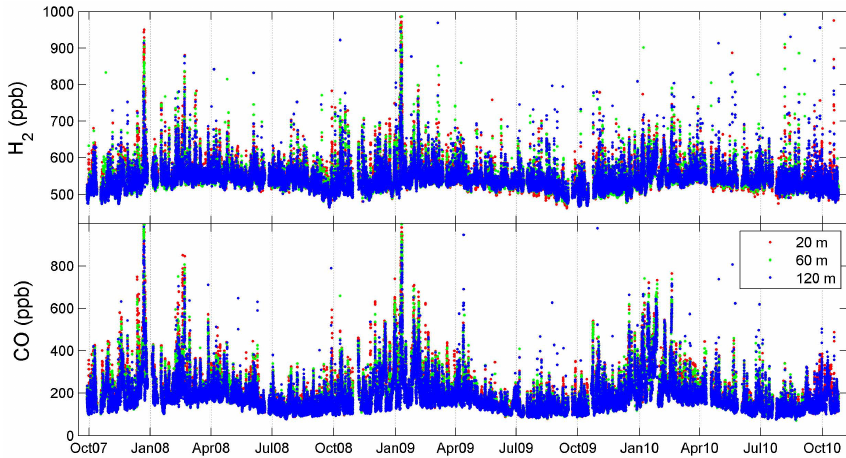
Fig. 3. Time series of H 2 and CO from three sampling heights. Different sampling heights are shown in different colours.